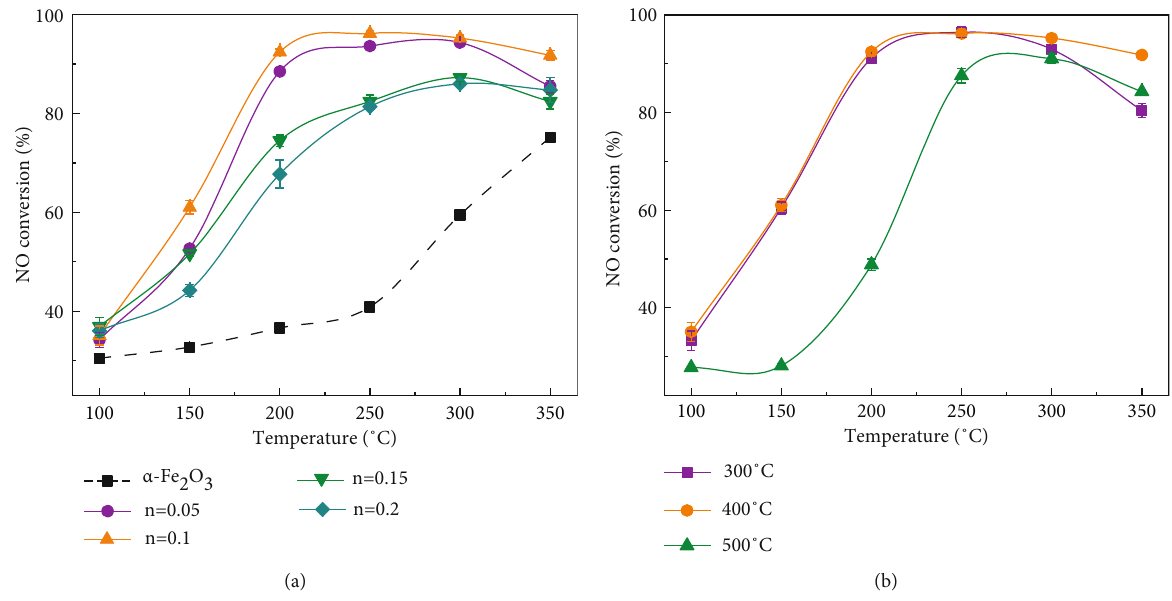
Figure 2: E ff ect of (a) di ff erent Mn/Fe molar ratio and (b) di ff erent calcinations temperatures on NO conversion e ffi ciency of